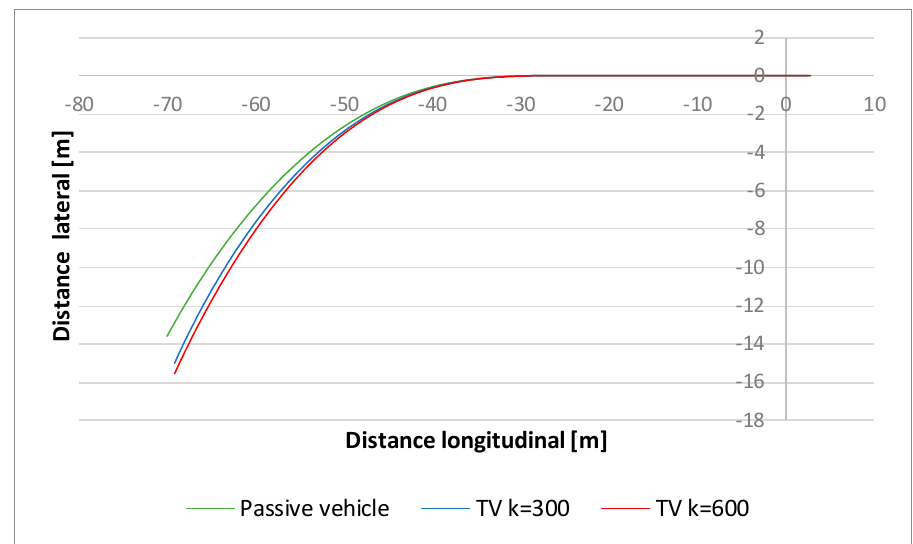
Figure 13. Trajectory after a 90° step steer for passive vehicle (green), TV k = 300 (blue), TV k = 600 (red).